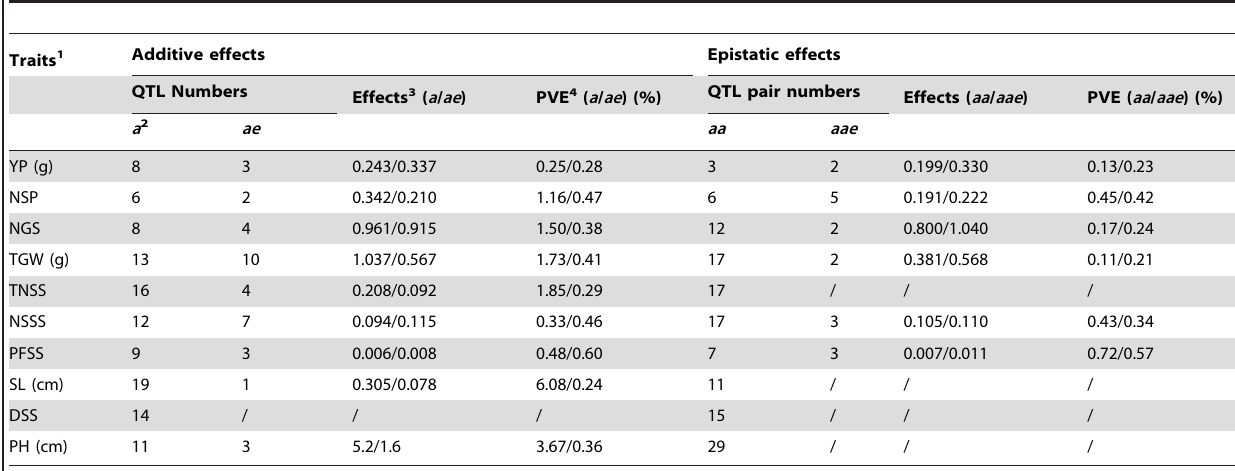
Table 7. Numbers and environmental interaction effects of QTLs for yield associated traits in wheat DH lines. Traits 1